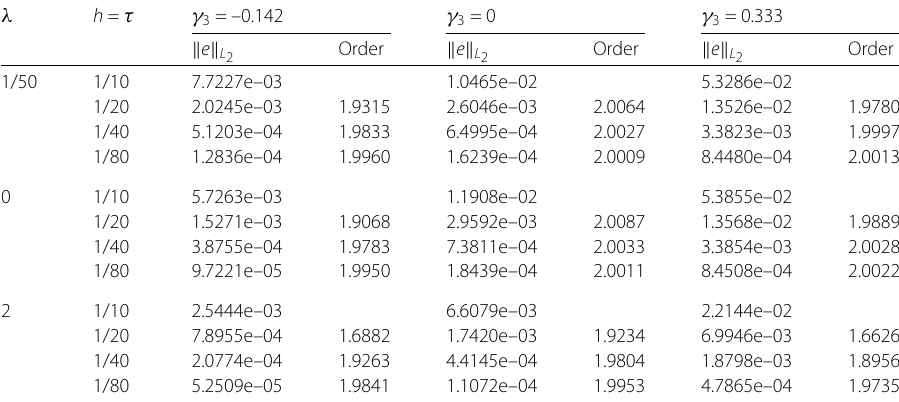
Table 2 Errors and corresponding observation orders at t = 1, α = 1.5